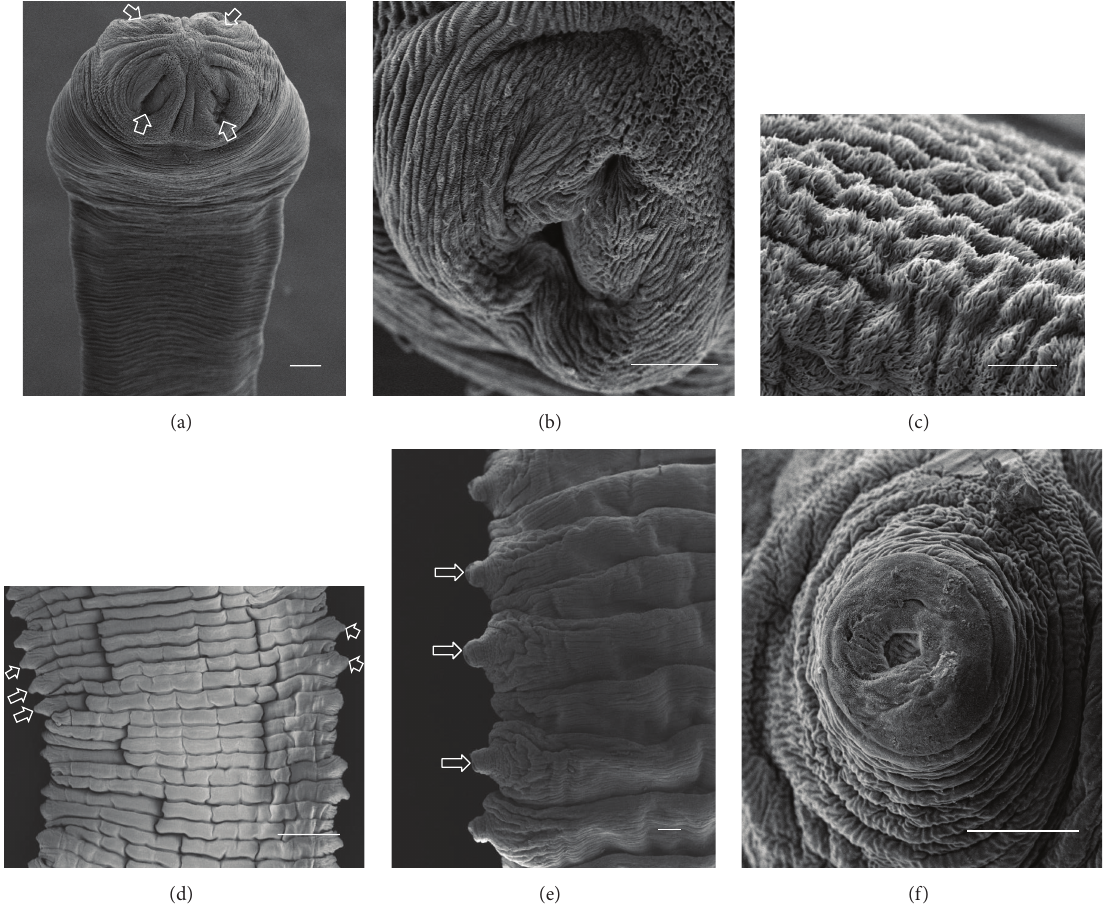
Figure 6: (a)–(f) Scanning electron micrographs of Thysaniezia ovilla . (a) General anterior view of scolex, arrows show invaginated suckers. (b) Invaginated sucker (scale bar, 50 𝜇 m). (c) Peripheral sucker showing capilliform filitriches (scale bar, 10 𝜇 m). (d) Portion of strobila showing genital pores irregularly altering (Scale bar, 1 𝜇 m). (e) Portion of proglottids, arrows show cirrus. (f) Cirrus apical view (scale bar, 50 𝜇 m). Scale bar = 100 𝜇 m, unless stated